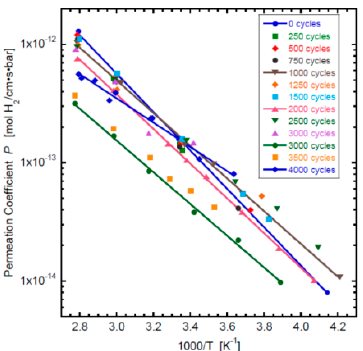
Figure 2. Arrhenius curves for HDPE [28].